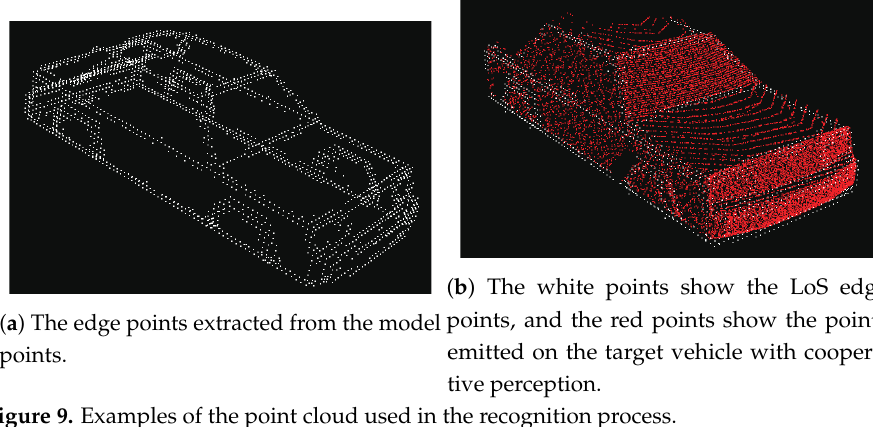
Figure 9. Examples of the point cloud used in the recognition